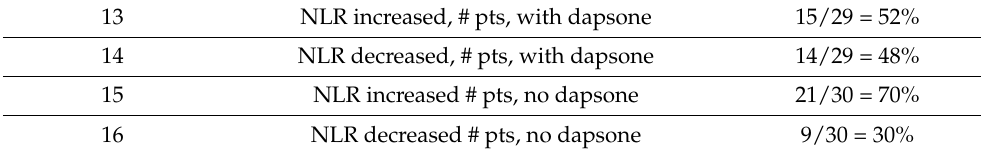
Table 2. Indications dapsone may lower the NLR during severe